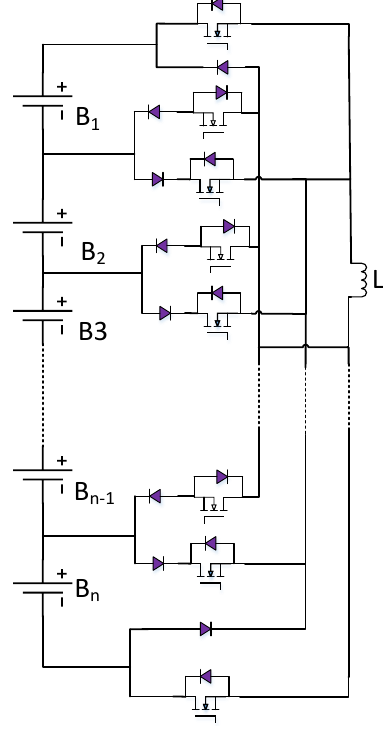
Figure 3. Balancing topology.